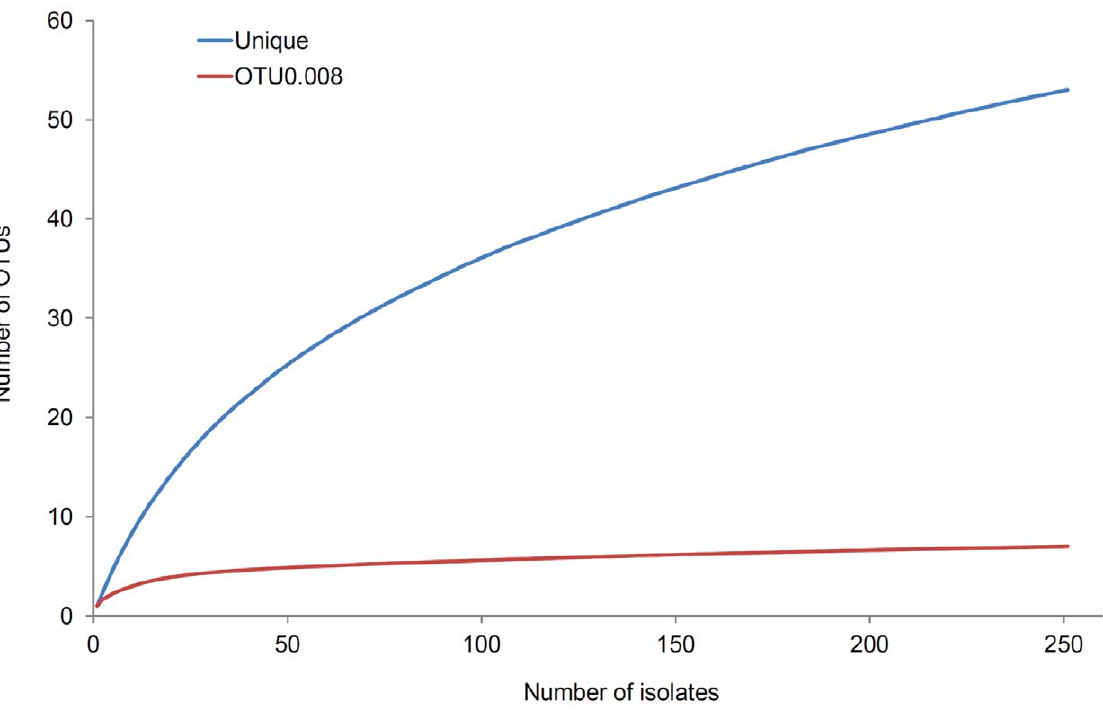
Figure 2. Rarefaction curves showing diversity by unique sequence type (ST) and Operational Taxonomical Unit (OTU). OTUs contained closely related STs, which were separated by the mean pairwise distance of the population, 0.008 (23/2874